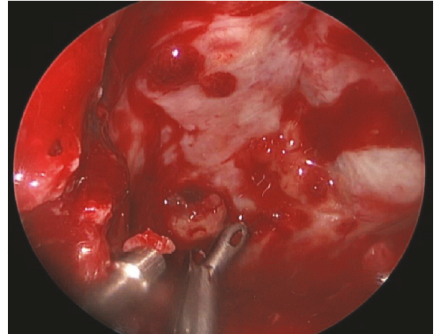
Figure 3: Removing of a solid lesion occupying the clival recess.